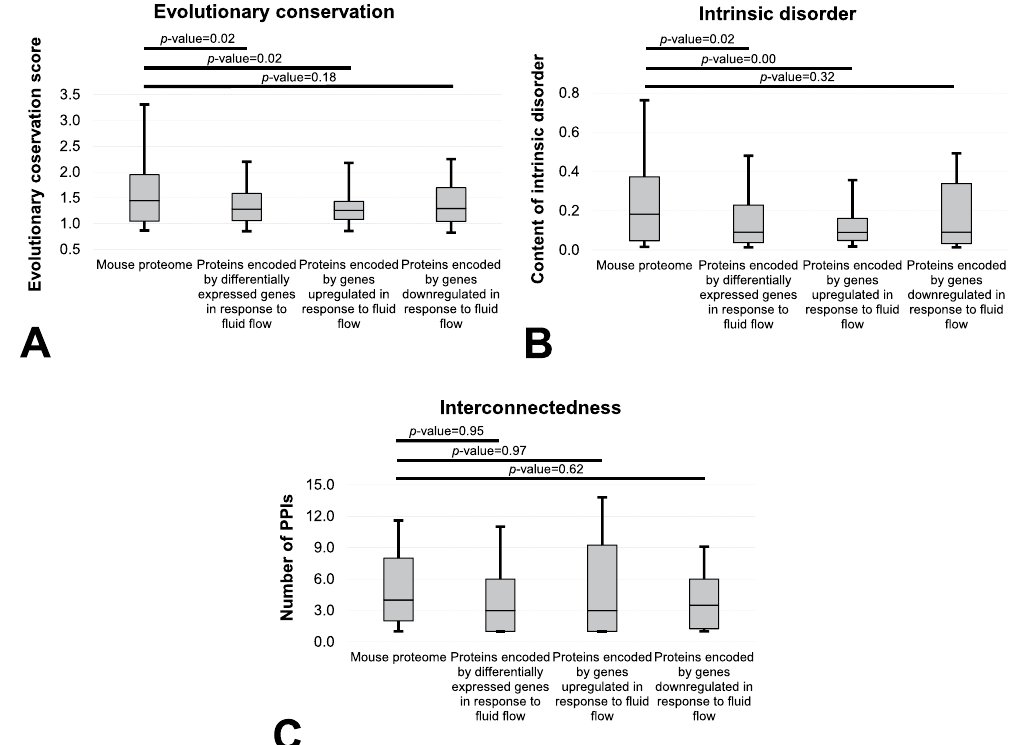
Figure 1. Comparison of the distrubutions of the evolutionary conservation quantified with the relative entropy scores (Panel A), content of the intrinsic disorder (Panel B) and the interconnectedness measured by the number of PPIs (Panel C) between the mouse proteins encoded by genes that are differentially expressed in response to fluid flow and a generic set of mouse proteins. The differentially expressed gene sets are also subdivided into upregulated and downregulated proteins. Distributions are represented with the box and whisker diagrams where the first quartile, second quartile (median) and third quartile are represented by the box and the whiskers correspond to the 10 th and 90 th centiles. Horizontal bars at the top of the figure summarize results of the analysis of statistical significance of the differences between the distribution for the two corresponding datasets. The significance was quantified with the two sample K-S test and the corresponding p - values are shown above the